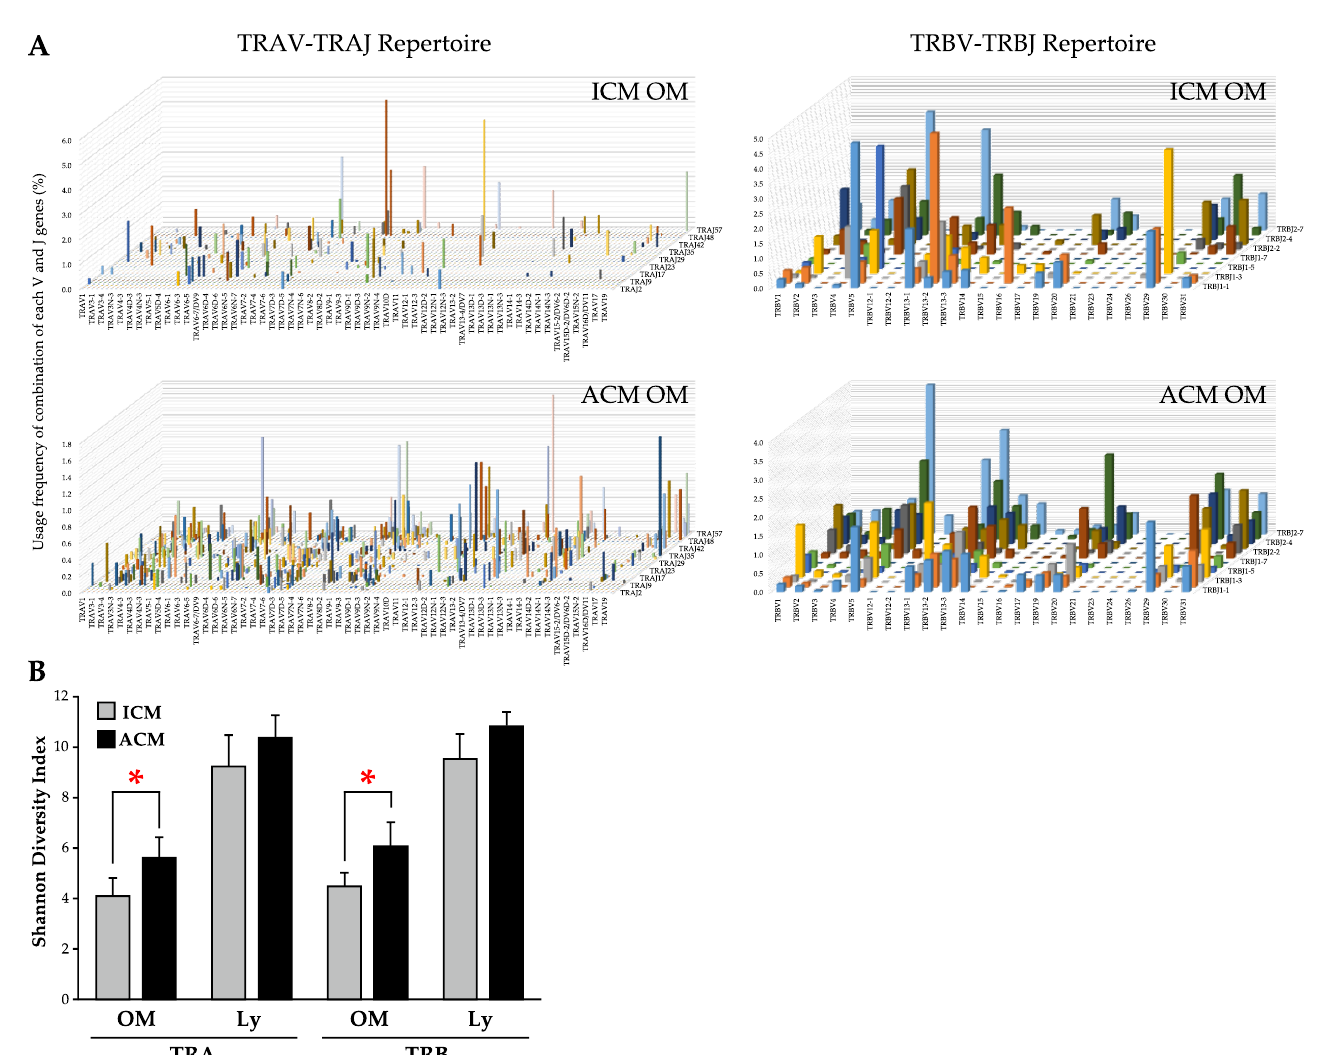
Figure 5. TCR repertoire analysis of the TRA and TRB in ICM and ACM mice. The NGS – based